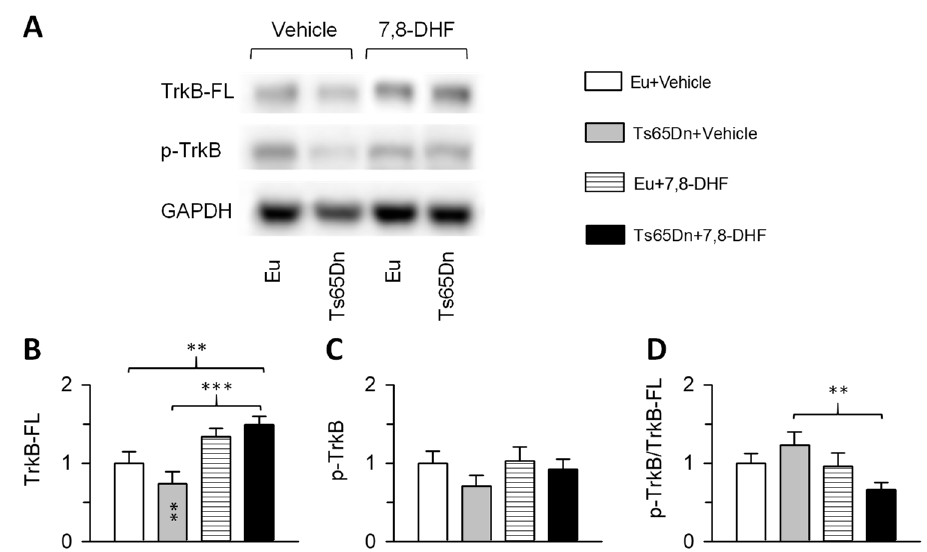
Figure 7. Effects of treatment with 7,8-DHF on the tropomyosin-related kinase receptor B (TrkB) receptor protein levels. ( A ): representative western blots showing immunoreactivity for the phosphorylated TrkB receptor (p-TrkB Tyr816 ), full length TrkB receptor (TrkB-FL), and housekeeping gene GAPDH. B-D: Levels of TrkB-FL ( B ), p-TrkB Tyr816 ( C ), and p-TrkB Tyr816 /TrkB-FL ( D ) of untreated euploid ( n = 8) and Ts65Dn ( n = 9) and treated euploid ( n = 7) and Ts65Dn ( n = 7) mice. Data are expressed as multiple of untreated euploid mice. Values are mean ± SE. ** p < 0.01; *** p < 0.001 (Fisher LSD test after two-way ANOVA). Asterisks in the gray bar indicate a difference between untreated Ts65Dn mice and treated euploid mice Abbreviations: 7,8-DHF, 7,8-dihydroxyflavone; Eu, euploid.